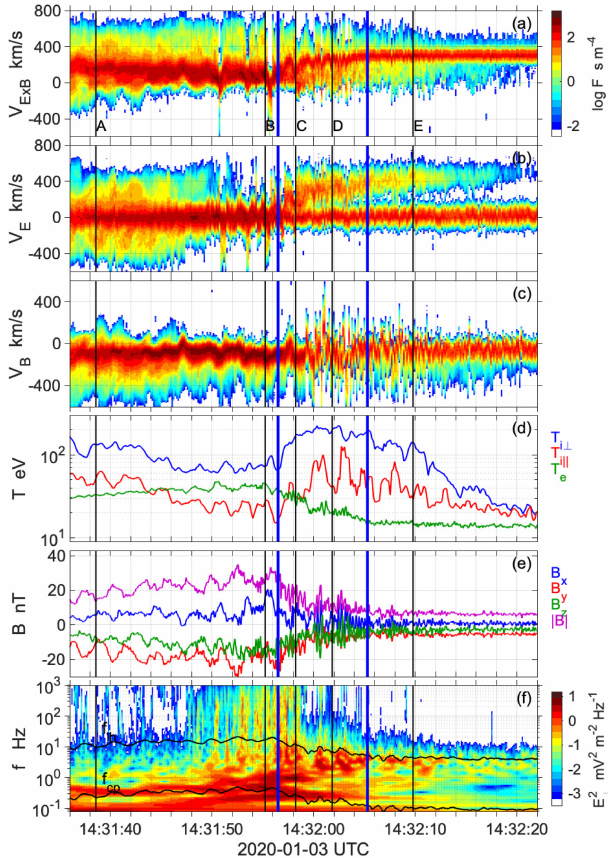
Figure 2. Shock no. 4 in burst mode measurements by MMS3 spacecraft. Panels (a) , (b) and (c) show reduced one-dimensional ion distribution functions F(v E × B ,t) , F(v E ,t) and F(v B ,t) , re- spectively. (d) Ion temperatures T i ⊥ , T i (cid:107) and T e measured by FPI. (e) Three components and modulus of the magnetic field in GSE system. (f) Time–frequency spectrogram of the perpendicular elec- tric field. Overlaid are the lower hybrid frequency f lh and the proton cyclotron frequency f cp . The shock ramp is within two blue vertical lines.